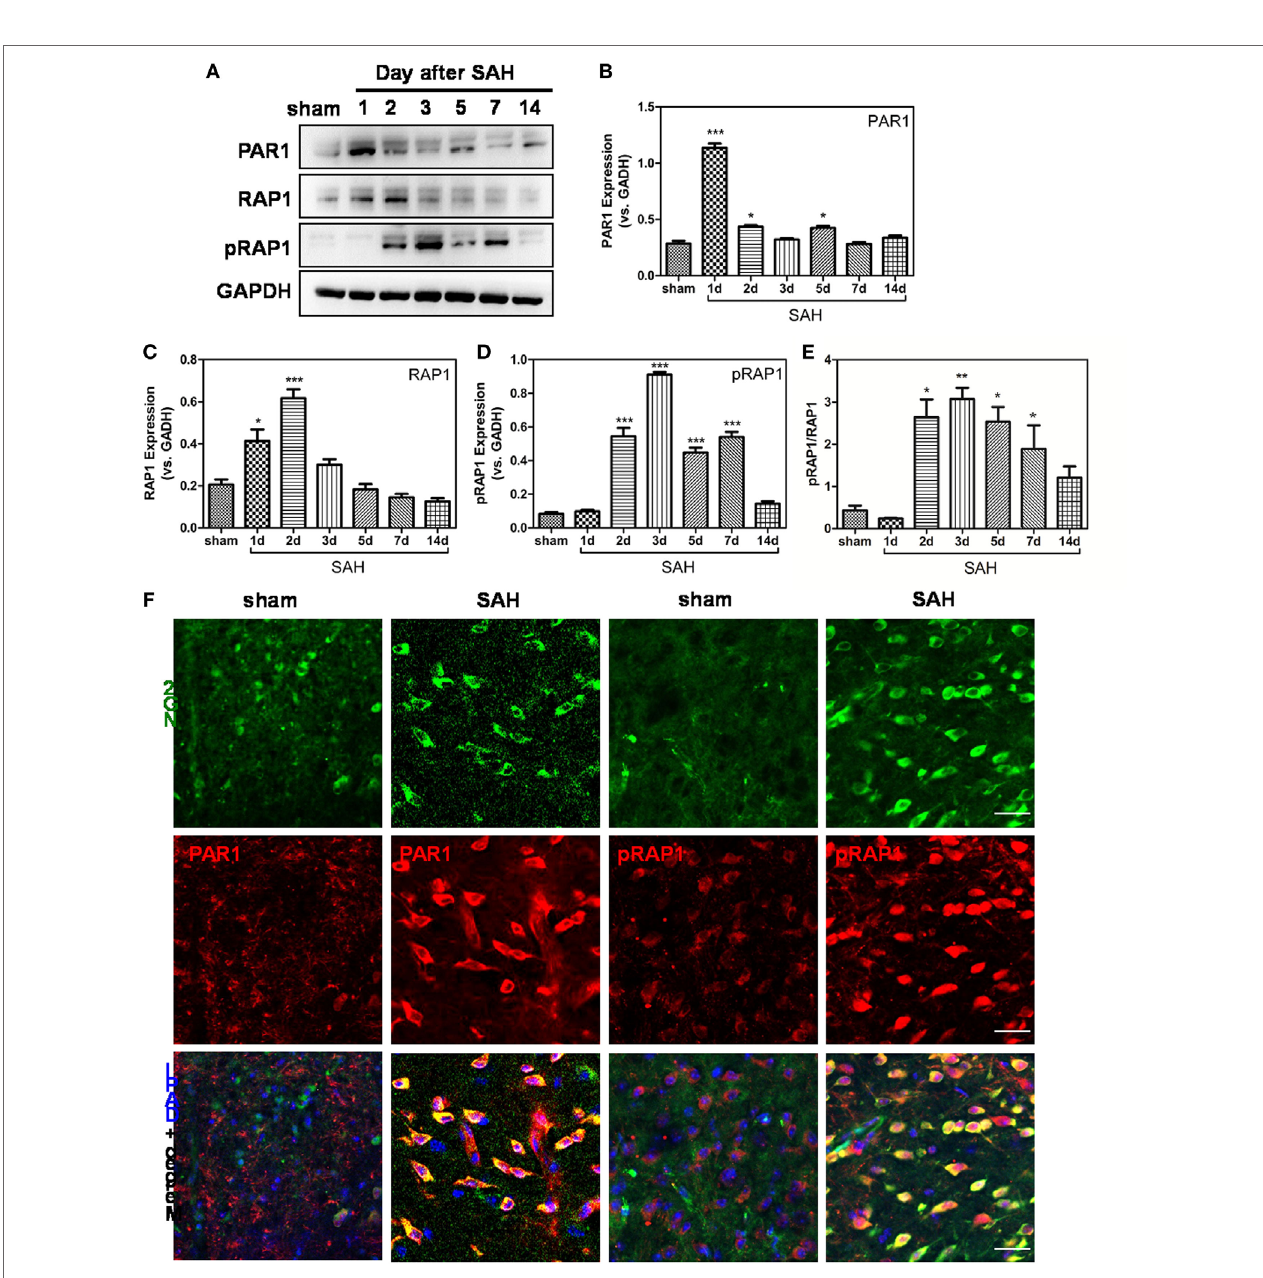
FigUre 4 | Genetic inhibition of nexilin impedes oligodendrocyte progenitor cell (OPC) migration in vitro . (a,B) Representative images of NG2/nexilin- and F-actin/ nexilin-positive cells on confocal dishes are shown. Scale bar = 20 µm. (c) Western blot analysis of nexilin and β -actin in cultured OPCs. (D) Schematic diagram of transwell chamber assays. Platelet-derived growth factor (10 ng/ml) was added to the lower chamber to induce the migration of OPCs. (e) Statistical histogram of the number of OPCs per mm 2 , n = 6 for each group. (F) Representative images of NG2- and F-actin-positive cells treated with scramble siRNA or nexilin siRNA are shown. The white arrow indicates cells in the migratory state. (g) Upper panel, schematic diagram of OPCs in the resting and migrating states; lower panel, statistical histogram of the percentage of migratory state OPCs. * P < 0.05 versus scramble siRNA group, ** P < 0.01 versus scramble siRNA group. SAH, subarachnoid hemorrhage.